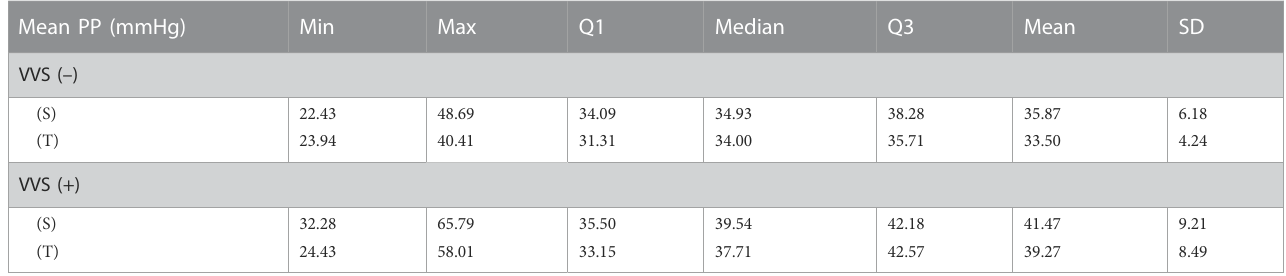
TABLE 1 Descriptive statistics of the mean pulse pressure (PP) values recorded during the tilt test: 5 min in supine (S) and 5 min in tilt (T) in the vasovagal female patients ’ group (VVS (+)) and control group (VVS ( – )). Mean PP (mmHg)